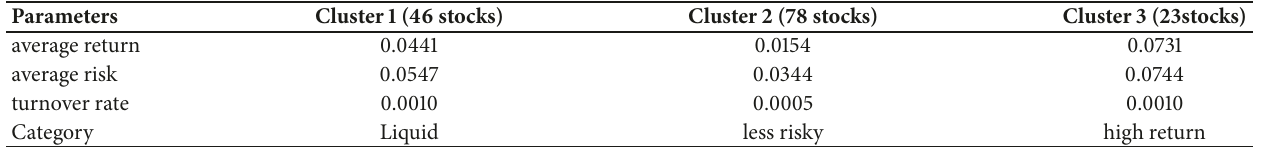
Table 1: Cluster result.